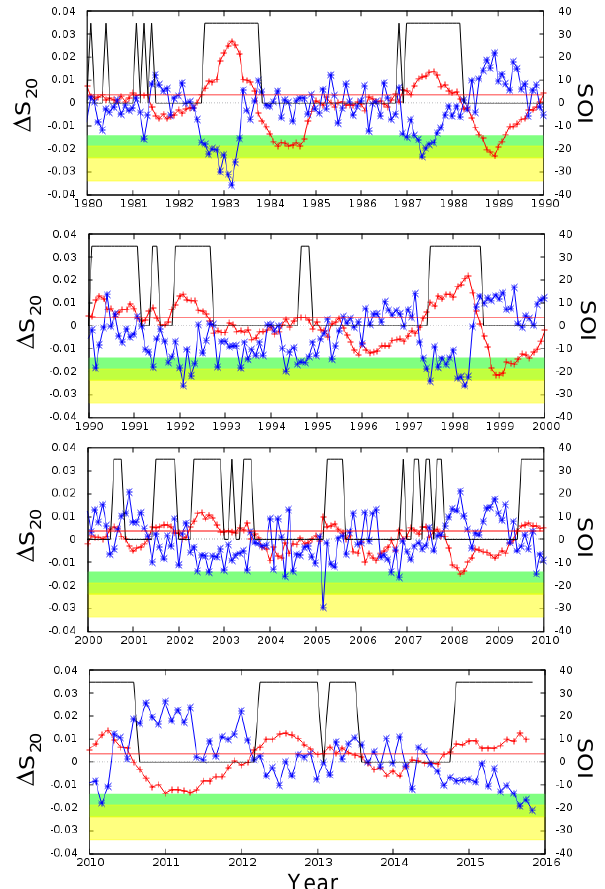
Figure 1. The entropy change (cid:49)S 20 in natural time for the win- dow length i = 20 months (red line, left scale) along with SOI monthly values (blue line, right scale) for the period January 1980– October 2015. The alarm is set on (black line), when (cid:49)S 20 exceeds the threshold value (cid:49)S thres = 0 . 0035.